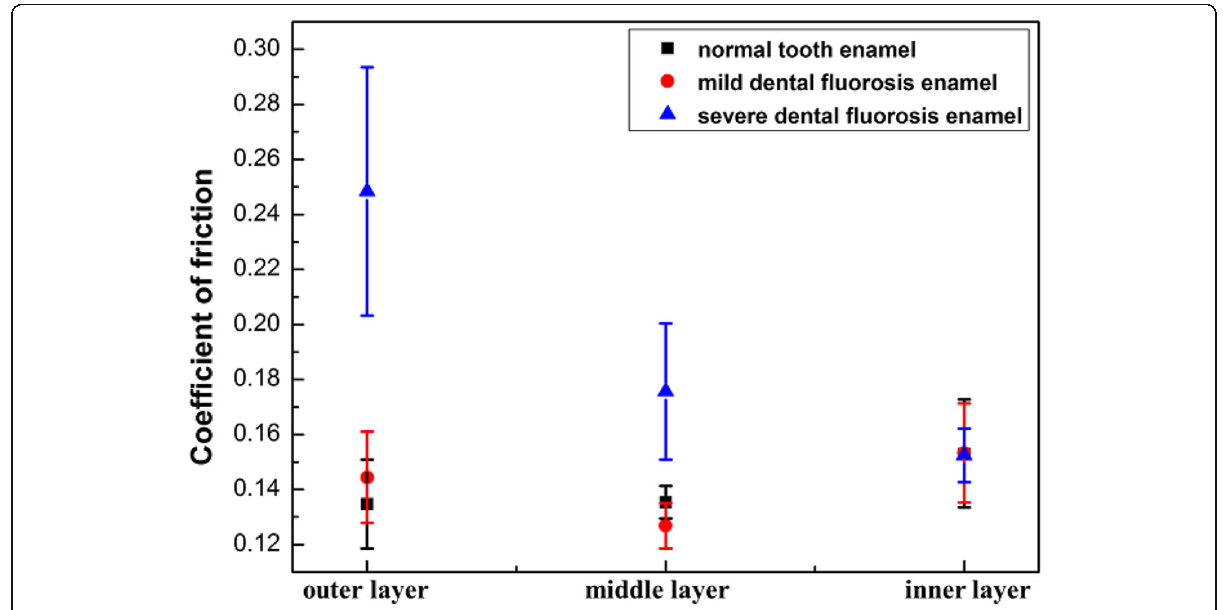
Fig. 5 Friction coefficients of the enamel layers of the normal tooth, mild dental fluorosis, and severe dental